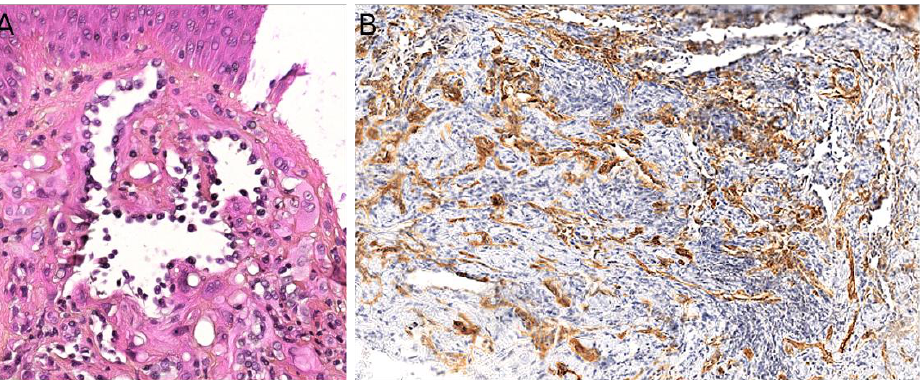
Figure 8. Papillary intralymphatic angioendothelioma: ( A ) Vascular proliferation with papillary tufts protruding from the vessel wall, lined by hobnail endothelial cells with large hyperchromatic nuclei (×200); ( B ) partial positivity for the lymphatic marker podoplanin (×100).